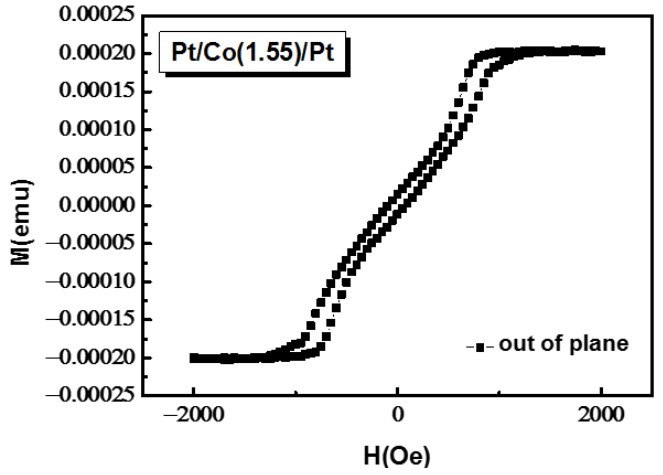
Figure A2. Room-temperature magnetic hysteresis loops measured along the out-of-plane direction. The saturation magnetic moment M under a saturated magnetic field is 0.0002044 emu, as shown in Figure A2. The multilayers under test are grown on a silicon wafer measuring 5 × 5 mm 2 . The total thickness of the magnetic layer is 6.2 nm. Easy to calculate the saturation magnetization . It could also be written as . 3 𝑀𝑀 𝑠𝑠 = 1320 emu/cm 𝑀𝑀 𝑠𝑠 = 1.32 kA/m